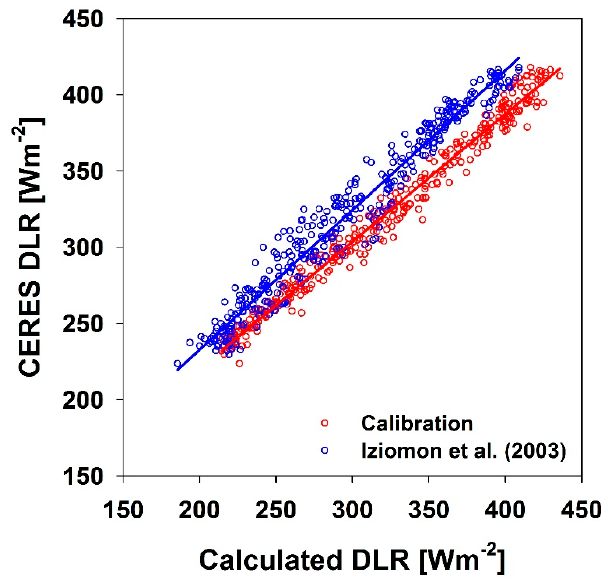
Figure 2. Scatter plot of calculated DLR (red: calibrated result in this study, blue: [71] method) and CERES DLR. Table 7. Regression coefficients for calculating DLR.